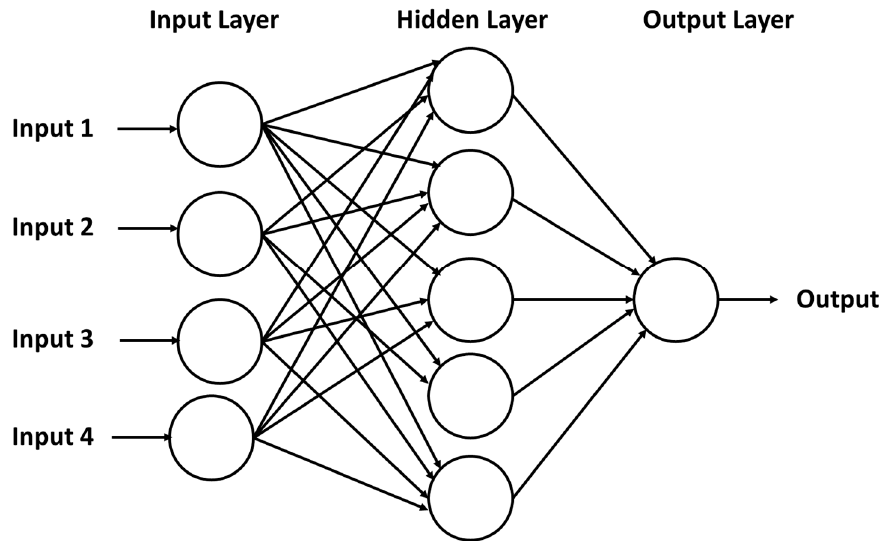
Figure 3 . A generic neural network with a single hidden layer used in this study [57]. Figure 3. A generic neural network with a single hidden layer used in this study